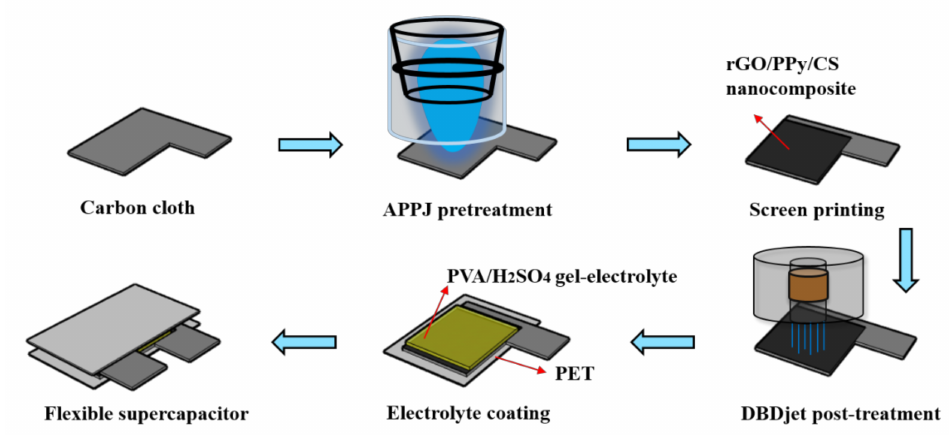
Figure 1. Schematic diagram of fabrication process of flexible